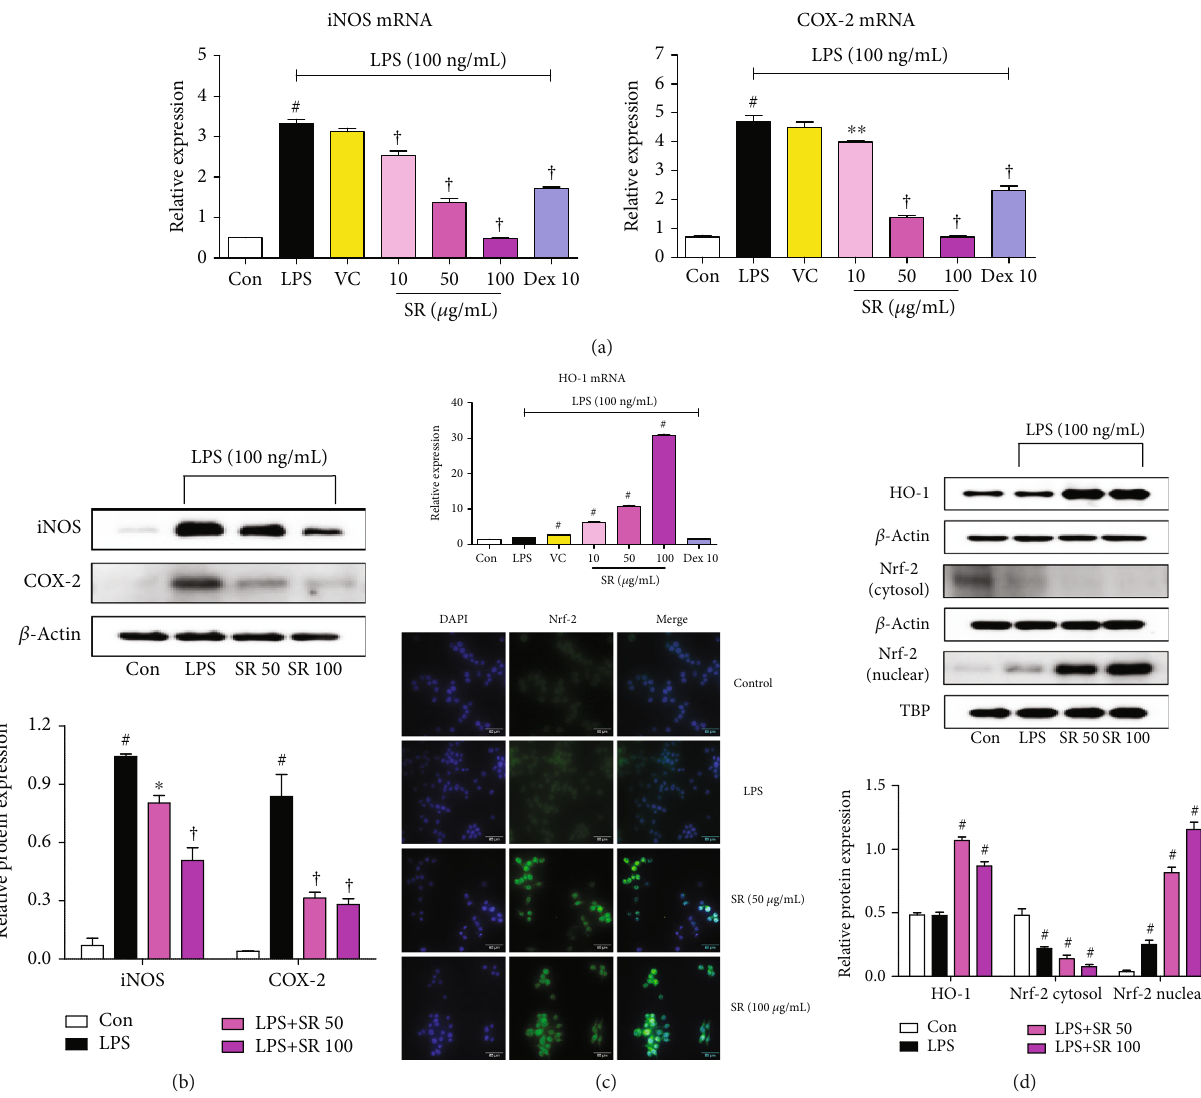
Figure 2: E ff ects of Saussureae Radix (SR) on (a, b) the expression of inducible nitric oxide synthase (iNOS) and cyclooxygenase- (COX-) 2, (c) the mRNA expression of heme oxygenase- (HO-) 1, and (d) the protein expression of HO-1 and nuclear translocation of nuclear factor erythroid 2-related factor 2 (Nrf-2). Control cells were incubated with only fresh DMEM. BV2 cells were stimulated with lipopolysaccharide (LPS) for 12 (iNOS and COX-2), 6 (HO-1 protein), or 3h (HO-1 mRNA and Nrf-2). (b, d) The histogram graphs show protein expression levels relative to those of the housekeeping protein. (d) The cultured BV2 microglia were incubated with anti-Nrf-2 (green) and DAPI (blue). Fluorescence was developed using the Alexa Fluor 488-conjugated anti-rabbit secondary antibody. # p < 0 : 05 (vs. control); ∗ p < 0 : 05 and † p < 0 : 001 (vs.